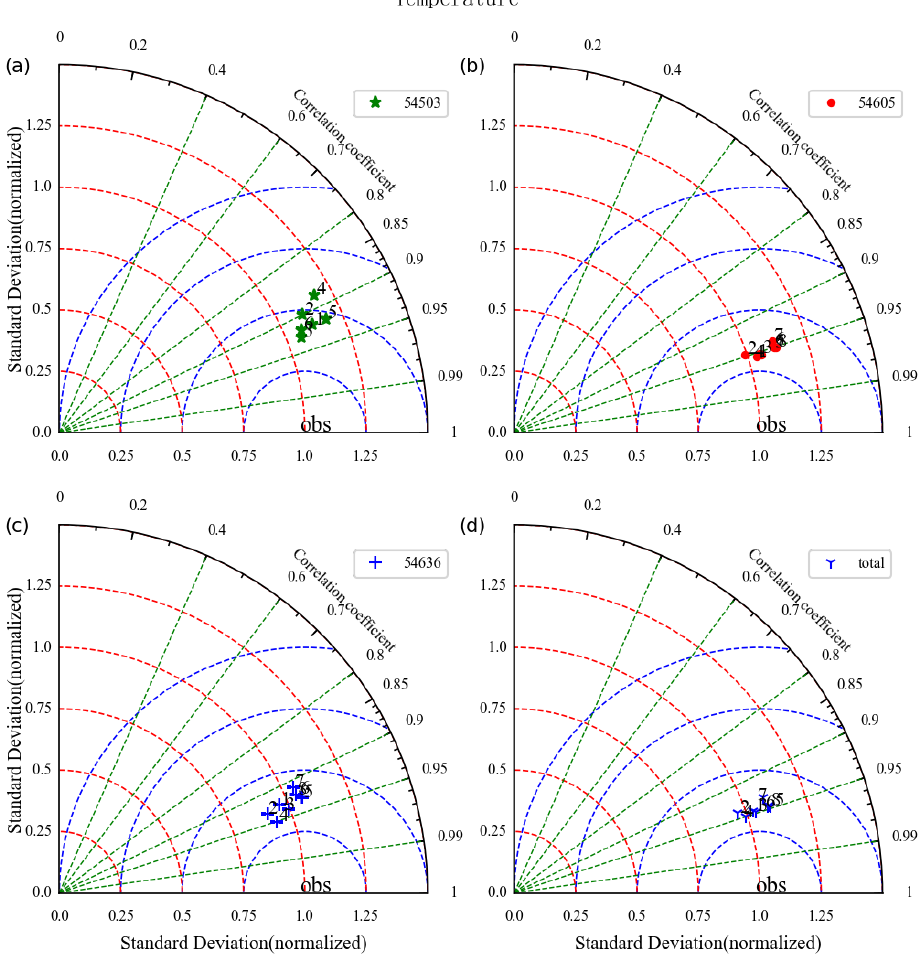
Figure 5. Taylor diagram of simulated and observed 2-m temperature values for different schemes during the simulation period at ( a ) Rongcheng: 54,503, ( b ) Xiongxian: 54,636, ( c ) Anxin: 54,605, and ( d ) total .